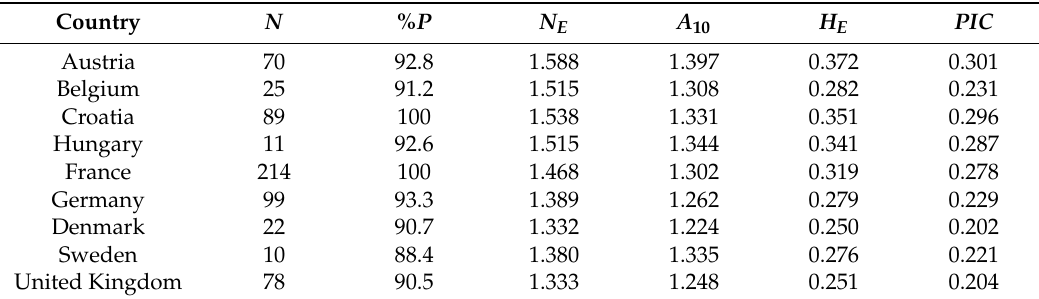
Table 4. Genetic diversity of 618 European wheat varieties from nine countries estimated based on 141 DArT markers.